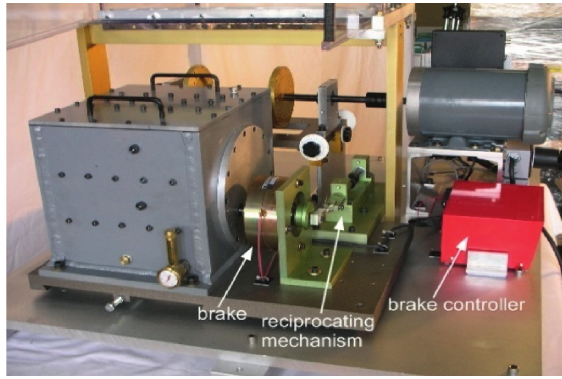
Figure 14: Gear fault experiment